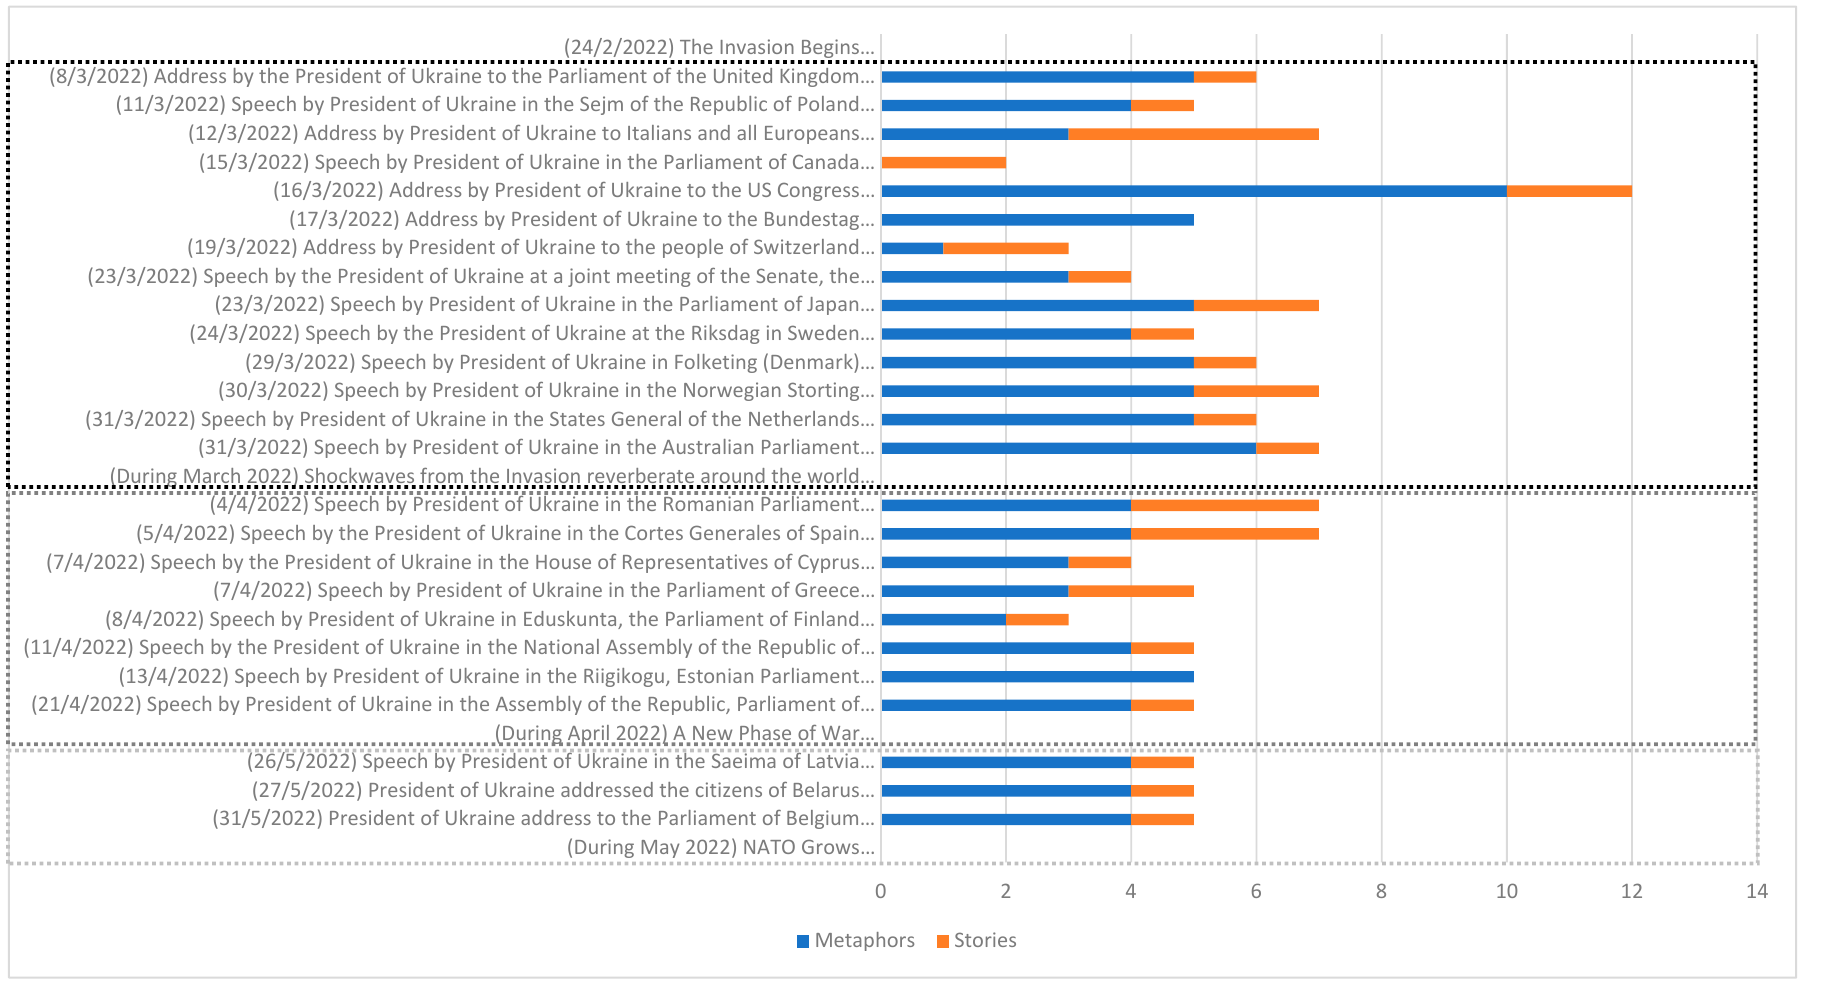
Figure 5. Number of Metaphors and Stories used by the Ukrainian President’s addresses are Positioned in the Timeline of Events.